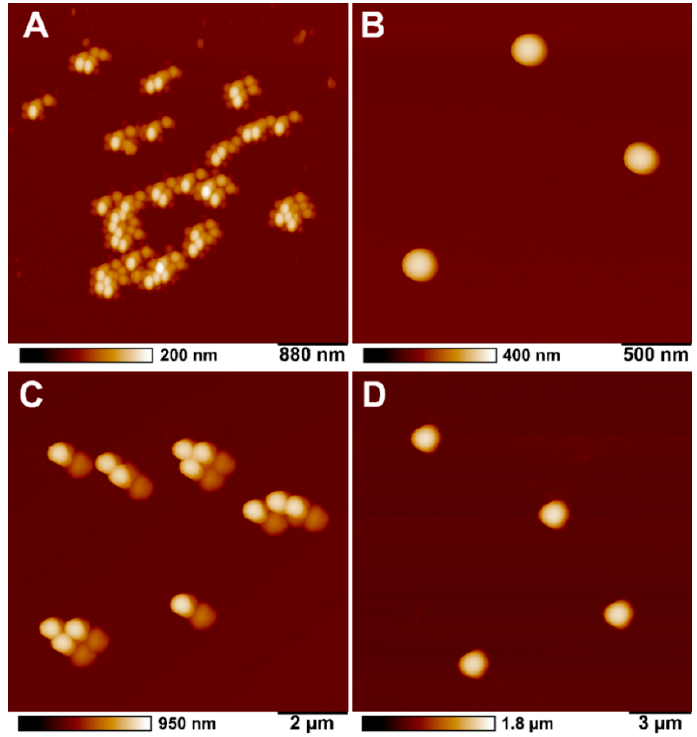
Figure 4. AFM images of ( A ) 100 nm, ( B ) 200 nm, ( C ) 500 nm, ( D ) 1 µm polystyrene particles.